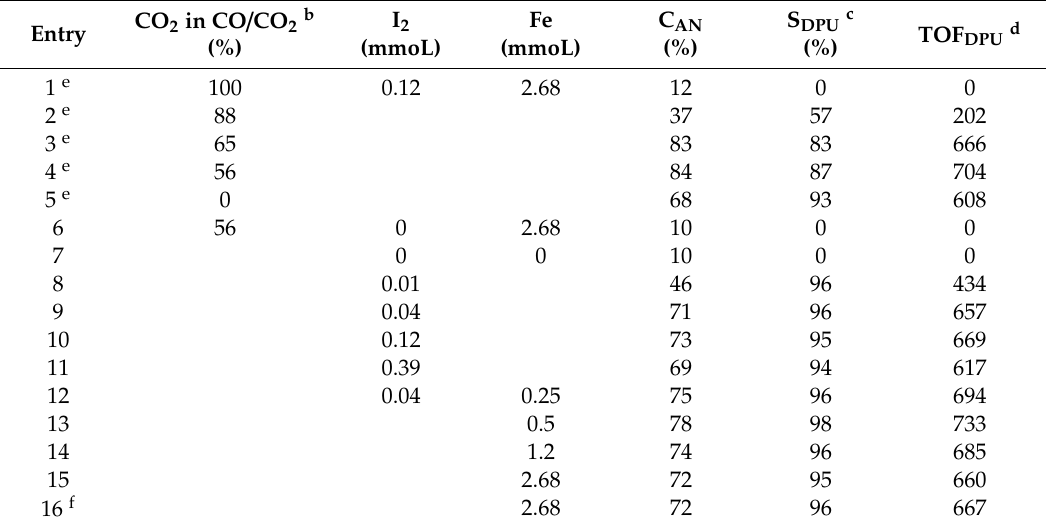
= 0.056 mmoL, AN = 54 mmoL, ethanol = 20 mL, a Reaction conditions unless stated otherwise: PdCl 2 (2,4Cl 2 Py) 2 3.8 MPa CO + CO 2 , 0.6 MPa O 2 , (100 ◦ C, 60 min, Py = pyridine, AN = aniline, DPU = N,N-diphenylurea. b For CO / O 2 :